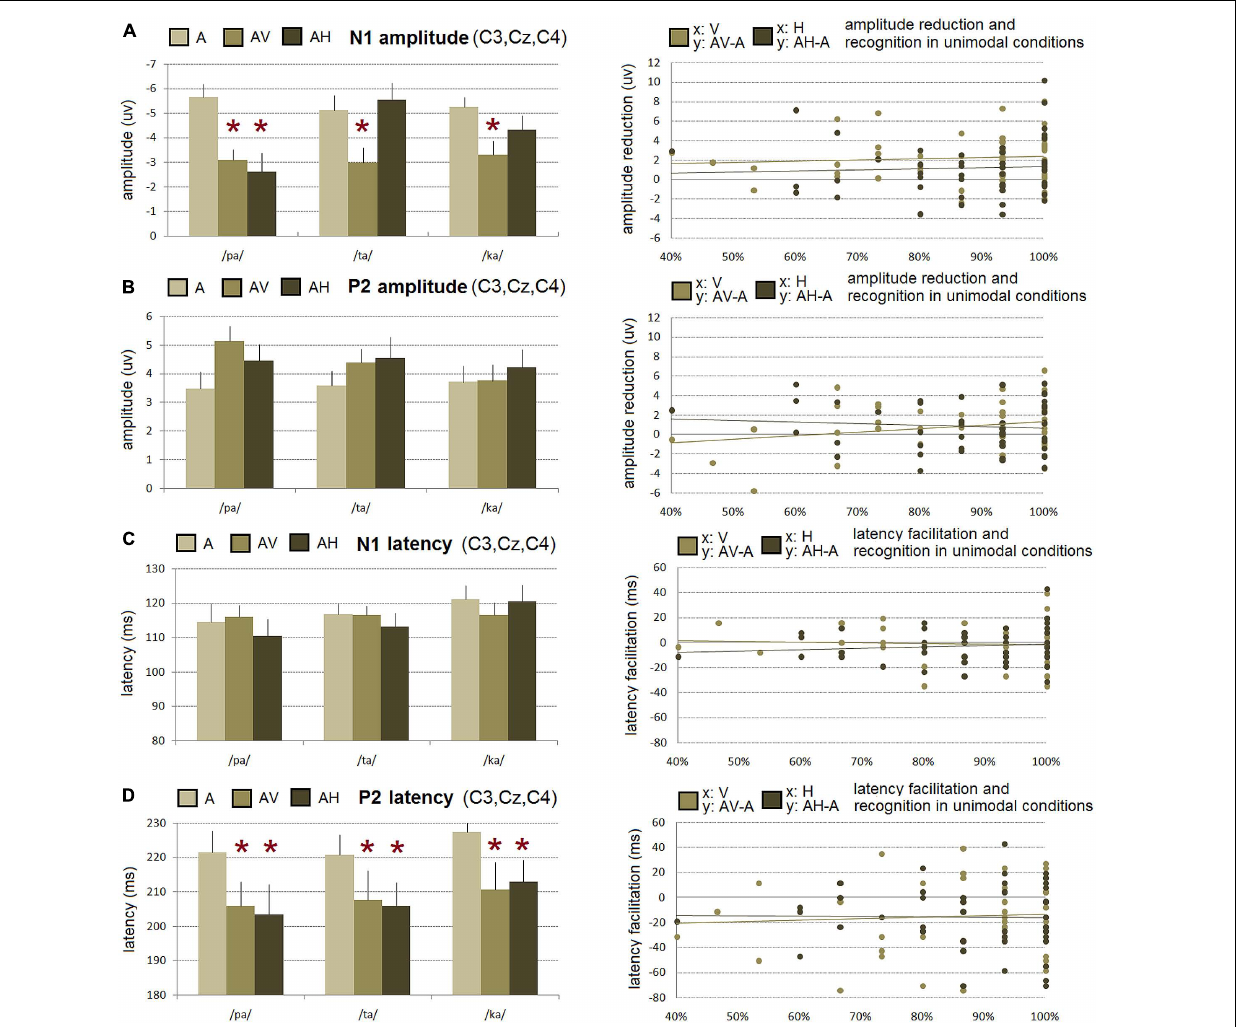
FIGURE 3 | Left. Mean N1 (A) and P2 (B) amplitude and mean N1 (C) and P2 (D) latency for /pa/, /ta/, and /ka/ syllables averaged over left (C3), middle (Cz), and right (C4) central electrodes in the auditory (A), audio-visual (AV), and audio-haptic (AH) modalities. Error bars represent standard errors of the mean. * indicates a significant effect.